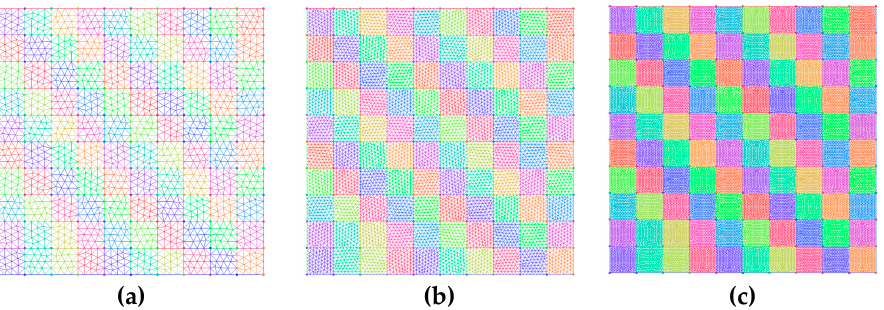
Figure 7. Heat transfer calculation results for steady-state problem of uniform internal heat source (( a ) FEMN solution and ( b ) analytical solution).